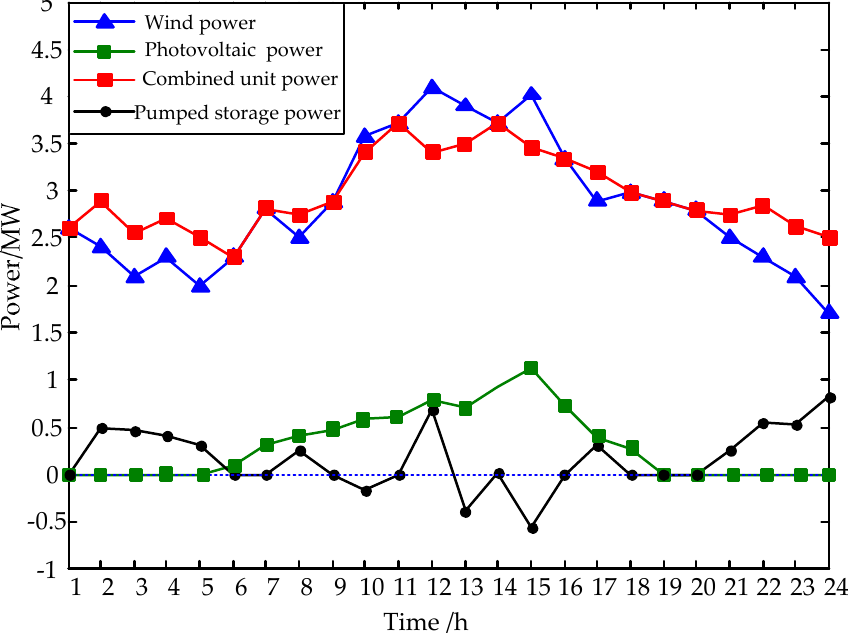
Figure 6. The output curve of each unit after the pumped storage energy flattens on typical day A.